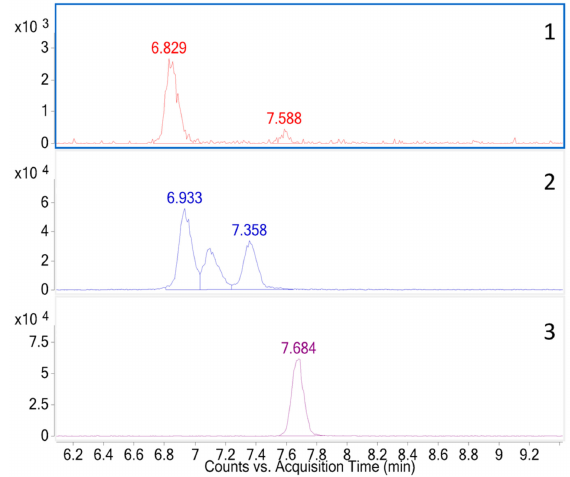
Figure 2. Extracted ion chromatogram of TFA cluster of sucrose (1), sucrose and maltose (2), and 13 C 12 trehalose (3) of negative electrospray HILIC